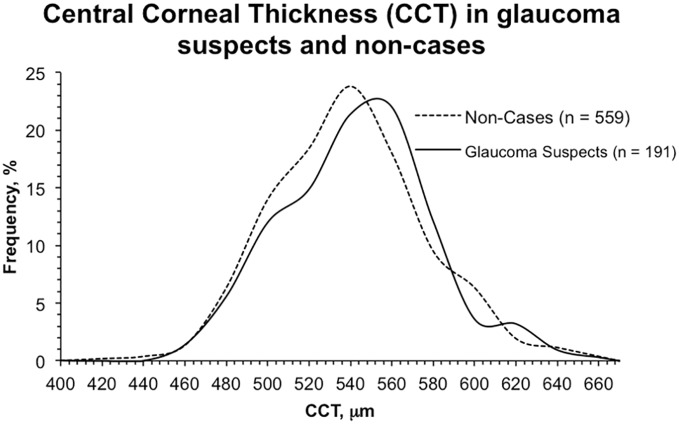
Frequency distribution curves for central corneal thickness in non-cases and glaucoma suspects.